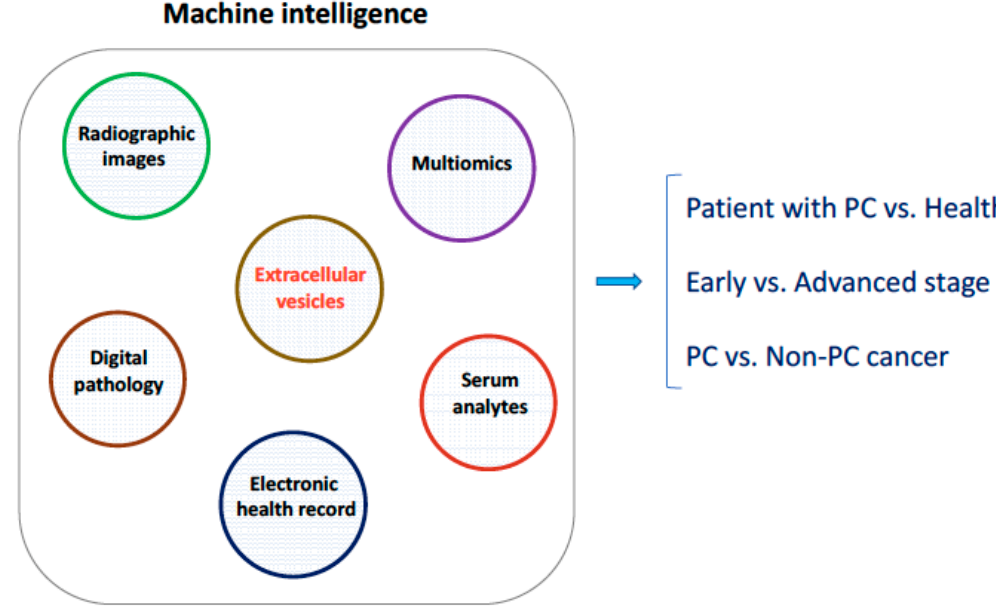
Figure 2. Integrative analysis of circulating EV-derived biomarkers with other datasets using machine learning-based algorithms for detection of pancreatic cancer (PC) in asymptomatic individuals, detection of PC at early stage, and distinguishing PC from other types of